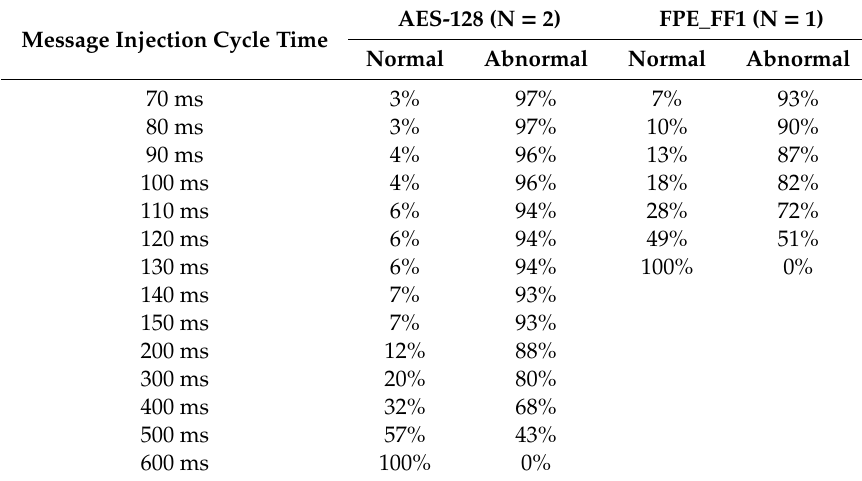
Table 8. Controller area network (CAN) message reception rate.